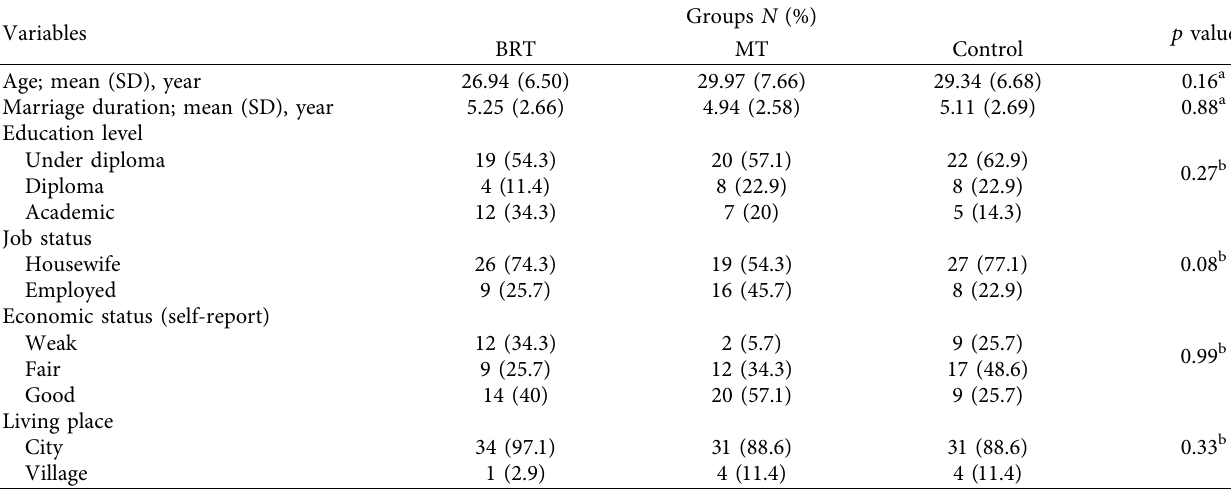
Table 1: Te demographic characteristics of the participants in the groups.